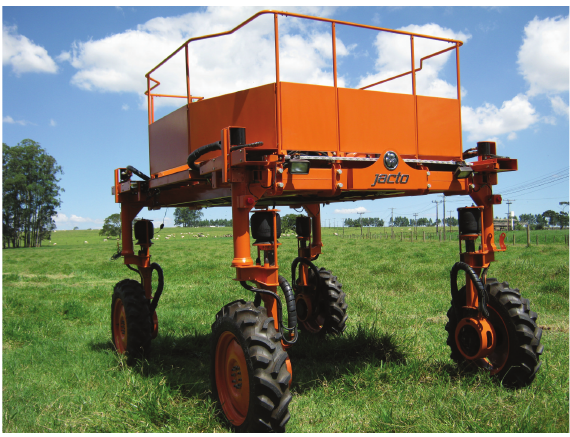
Figure 1: Agricultural robotic platform: Agribot.